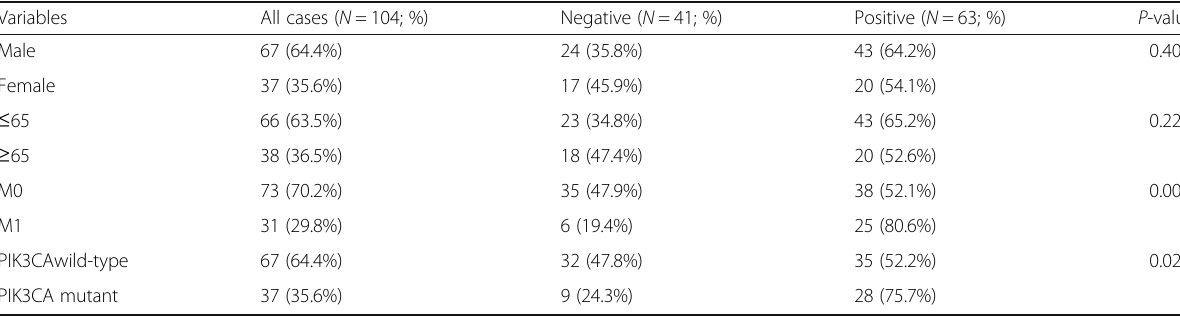
Table 3 Clinicopathological variables of 104 CRC patients and their correlation with Raptor expression